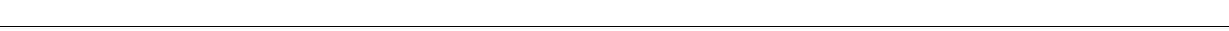
Fig. 5 Sox10-dependent enhancer activation is stimulated by Nfatc2 and inhibited by Olig2 and Nkx2.2. a Transient transfections of N2a cells with luciferase reporters carrying Nkx2.2 ECR19 in the absence ( − ) or presence ( + ) of Sox10 and constitutively active Nfatc2 as effectors ( n = 3). Activation of reporter gene expression was determined in extracts 48 h post transfection and is presented as fold inductions ± SEM with transfections in the absence of effectors arbitrarily set to 1 (58.5 ± 4.0 for Sox10, 0.3 ± 0.0 for Nfatc2, and 130.5 ± 11.6 for Sox10 in combination with Nfatc2). b , c Neural